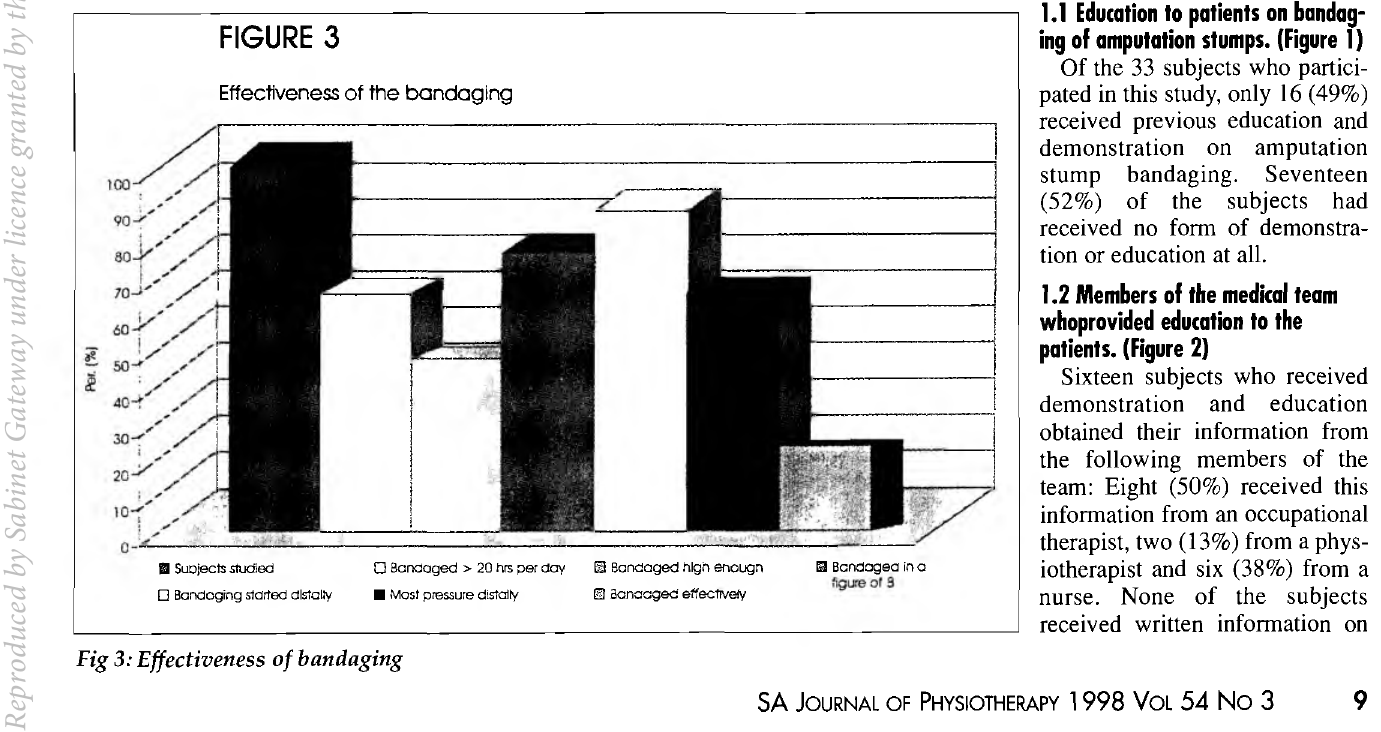
Effectiveness of the